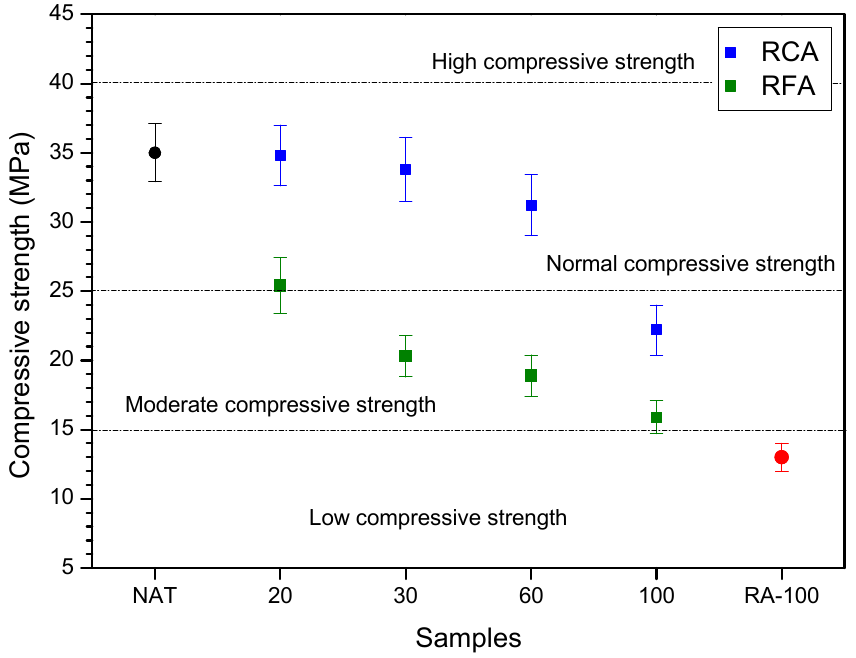
Figure 6. A typical Nyquist diagram of electrochemical impedance spectroscopy (EIS) studies at high frequencies.